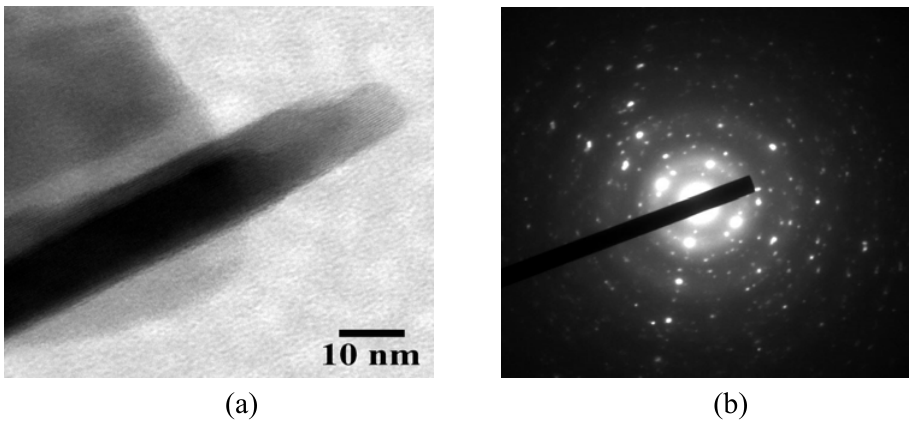
Figure 4. (a) High-resolution TEM image and (b) corresponding selected area diffraction pattern of MWCNT-doped WO thin 3